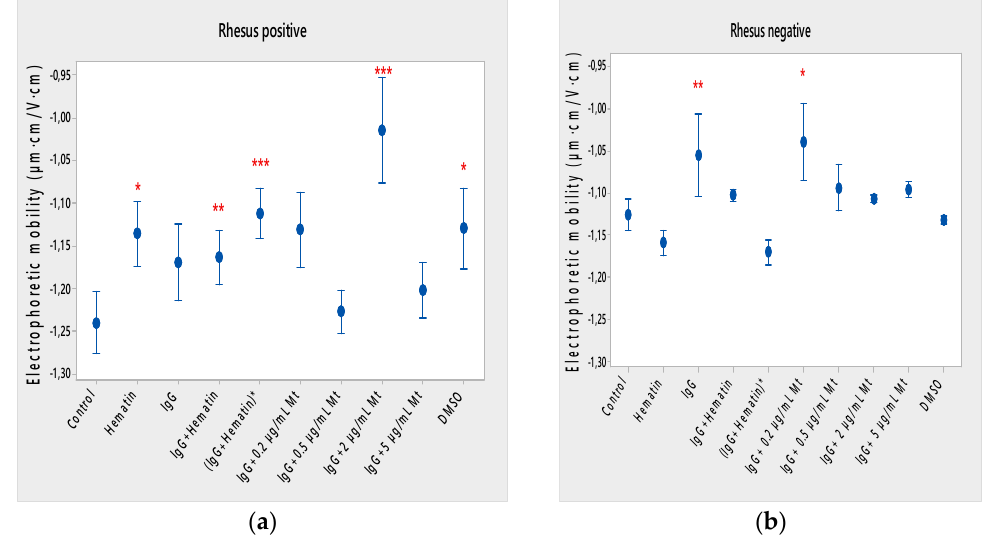
Figure 2. Effect of fixed concentrations of pooled immunoglobulin G (10 mg/mL), hematin (80 µM) and melittin (0.2 µg/mL Mt; 0.5 µg/mL Mt; 2 µg/mL Mt and 5 µg/mL Mt) treatments on electrophoretic mobility (EPM) (average value ± SD) of erythrocytes ( a ) with a Rhesus-positive factor and ( b ) Rhesus-negative factor suspended in PBS, pH 7.4. The pre-incubated sample of pooled immunoglobulin G (10 mg/mL) with hematin (80 µM) is indicated by an asterisk on the abscissa. Erythrocytes were treated with biomacromolecules for 1 h at 37 °C. Electrophoretic mobility was performed at 25 ± 0.1 °C in phosphate buffered saline (PBS), pH 7.4. Each value was the mean ± SD of three independent preparations. *** p < 0.001; ** p < 0.01; * p < 0.05 compared to the untreated control and compared to DMSO (80 µM)-treated control (green asterisks).